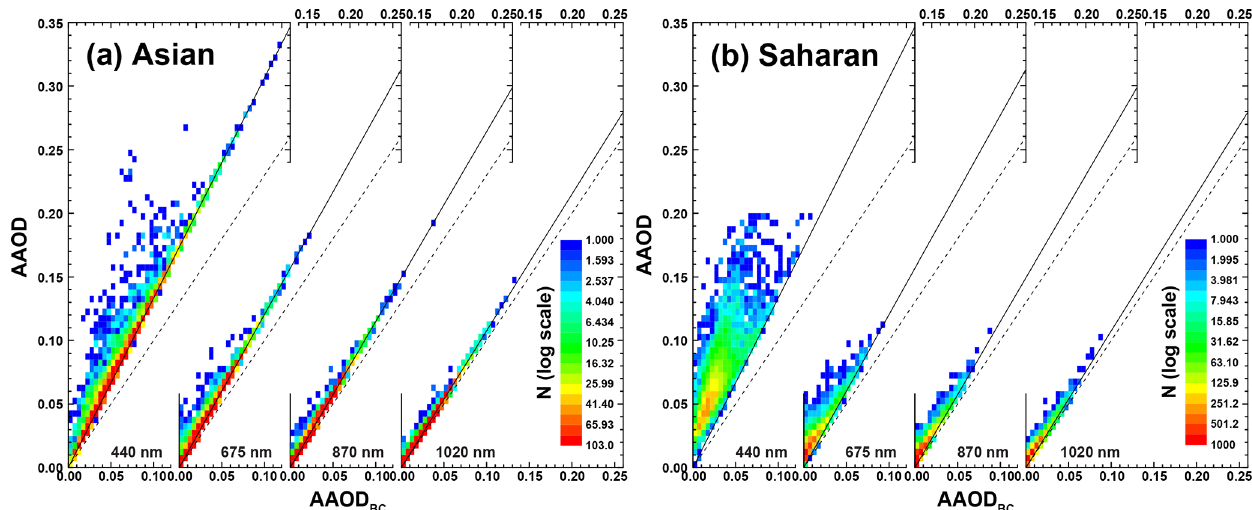
Figure 7. Two-dimensional histograms of AAOD and AAOD BC at the four AERONET standard wavelengths for the Asian (a) and Saha- ran (b) stations considered in this study. Solid lines refer to the theoretical values of AAOD BC (using Eq. 15 and the values in Table 1) in the absence of mineral dust. Dashed lines mark the 1:1 line. Observations would follow this slope only if BC was a perfect absorber, i.e. if all absorption in the non-dust fraction was caused by BC or ω BC = 0.